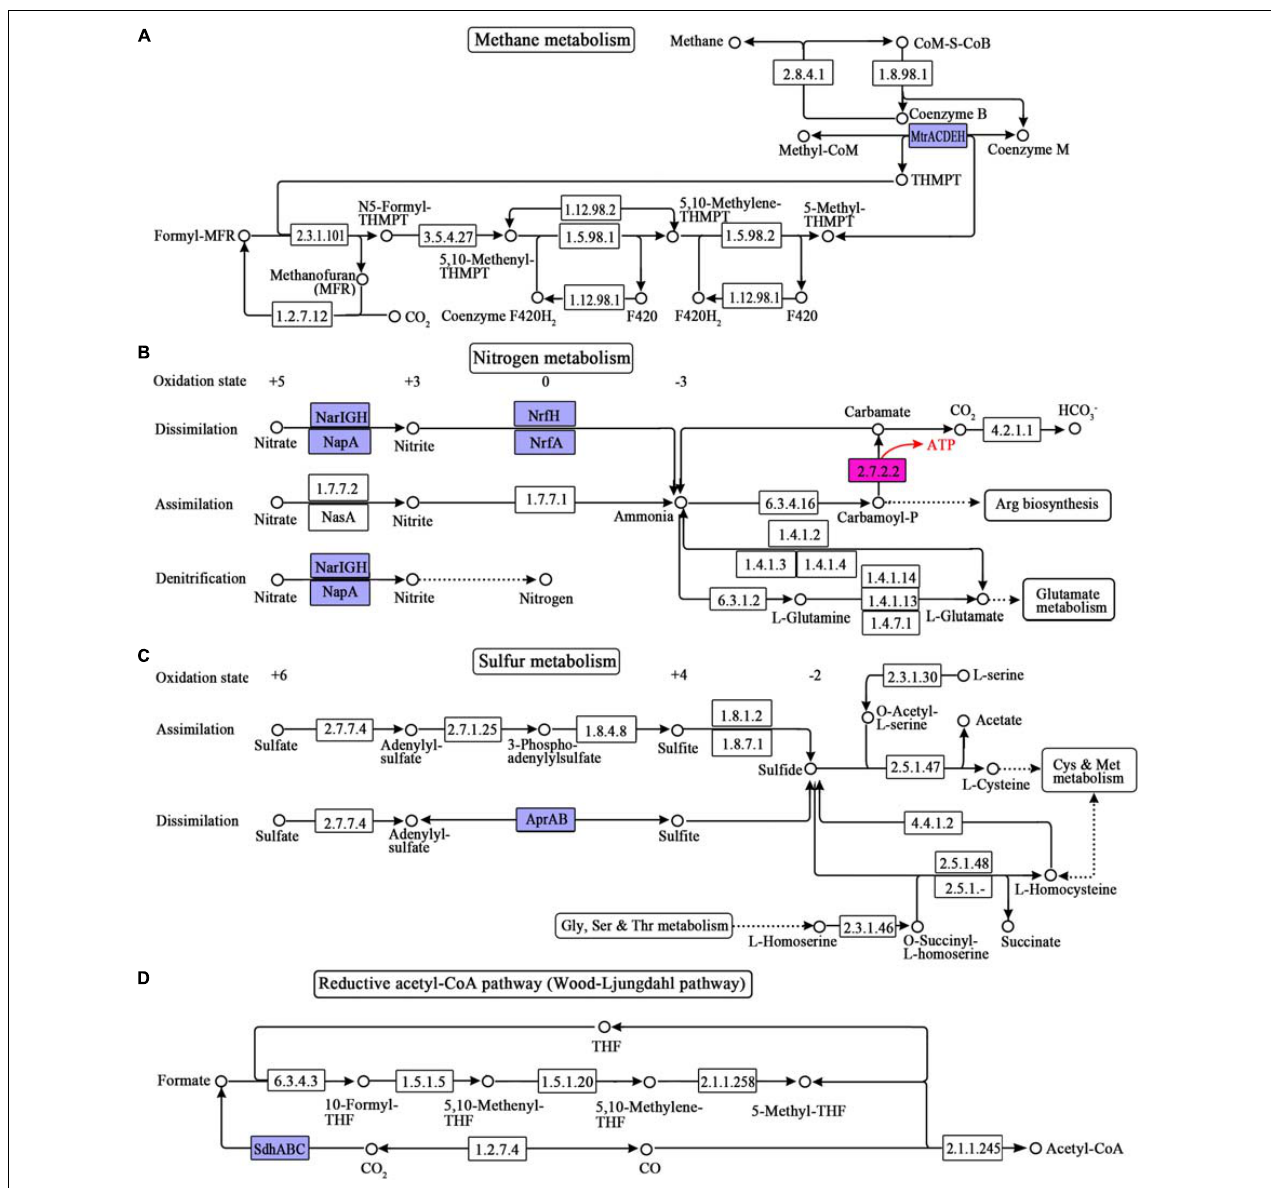
FIGURE 2 | ETP-related pathways reconstructed from the metagenome sequences of the ruminal microbiome. (A) Methane metabolism; (B) nitrogen metabolism; (C) sulfur metabolism; (D) reductive acetyl-CoA pathway (Wood-Ljungdahl pathway). The numbers in the boxes represent the EC numbers of pathway enzymes. The box in pink refers to the SLP enzymes. The box in blue refers to the electron transporter. THF is the abbreviation of tetrahydrofuran. THMPT is the abbreviation of tetrahydromethanopterin. KO numbers and gene annotation of the enzymes are shown in Supplementary Table 1